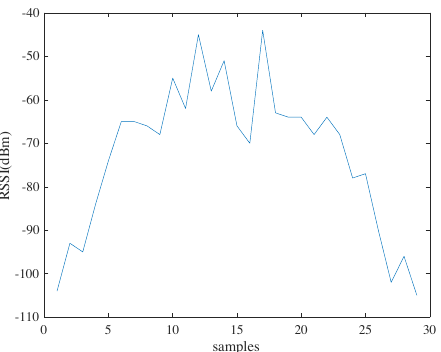
Figure 5. The RSSI readings when a user holding the receiver (phone) starts from a place far away from the beacon, walks near the beacon, and then